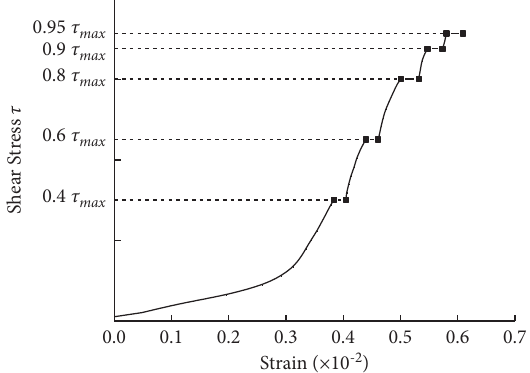
Figure 10: Relaxation curves of 10 ° discontinuities by different treatment processes: (a) τ σ � 3.924MPa.